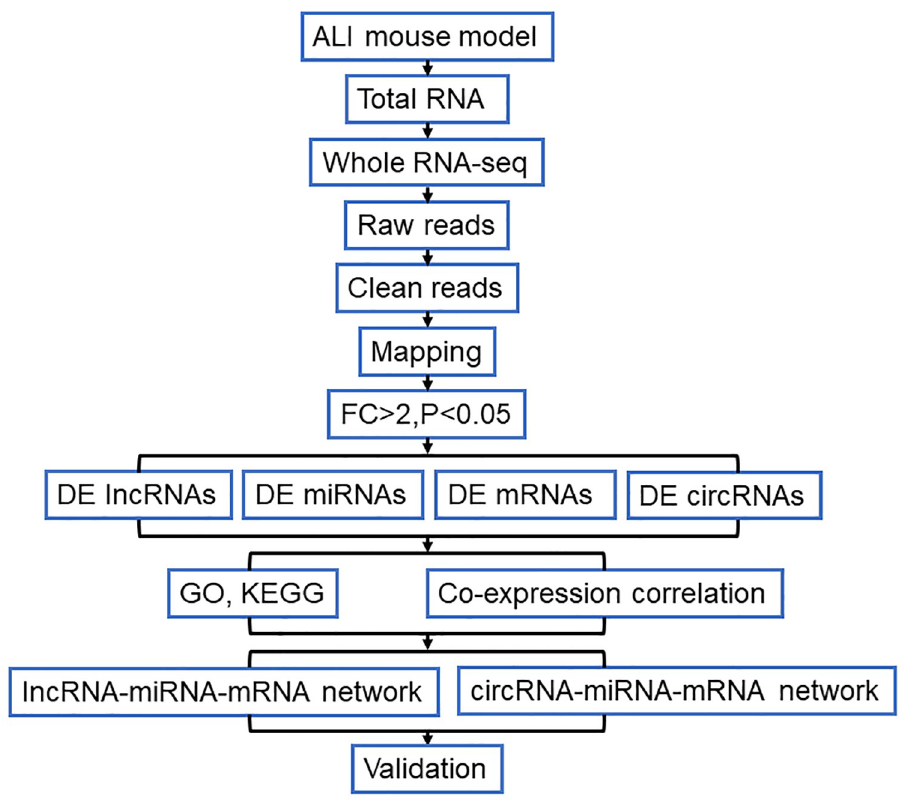
Fig 1. Flowchart for analysis of the whole-transcriptome sequencing